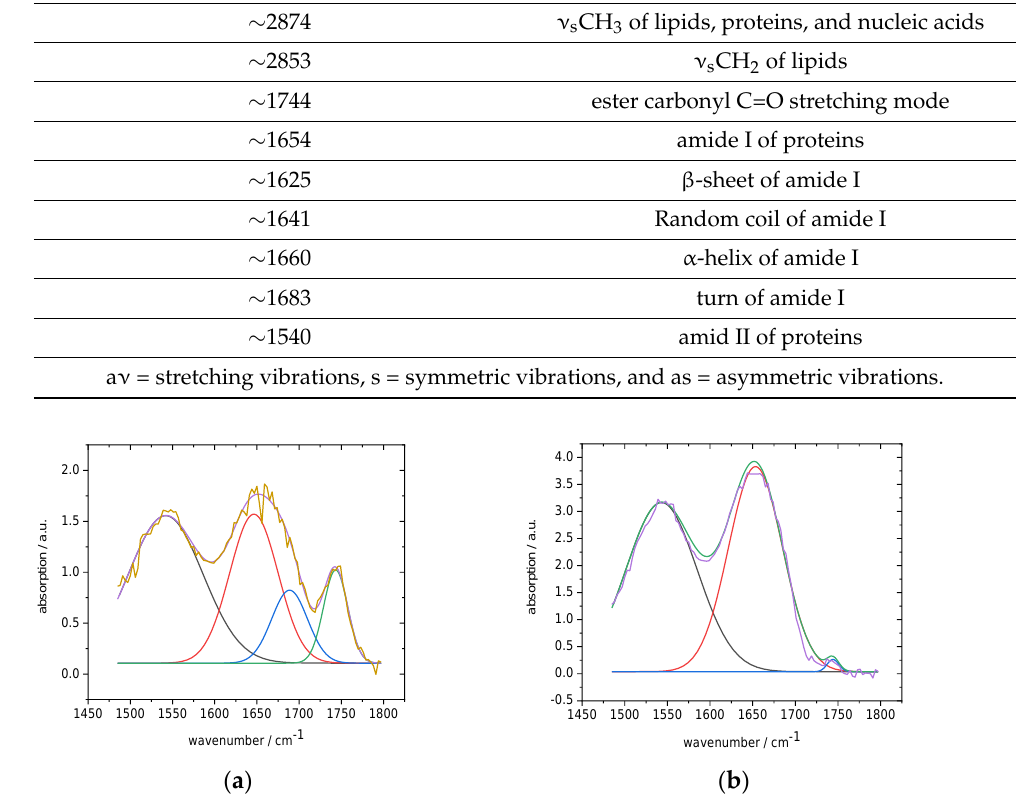
Figure 3. Fitted spectral range from 1450 to 1800 cm -1 : ( a ) control group ( b ) BPC 157-treated group. Table 2. Initial fitting parameters. Four Gaussians for the control group and three Gaussians for the BPC-treated group, with maximal number of iterations = 200 and tolerance = 10 − 6 . Control Group Peak